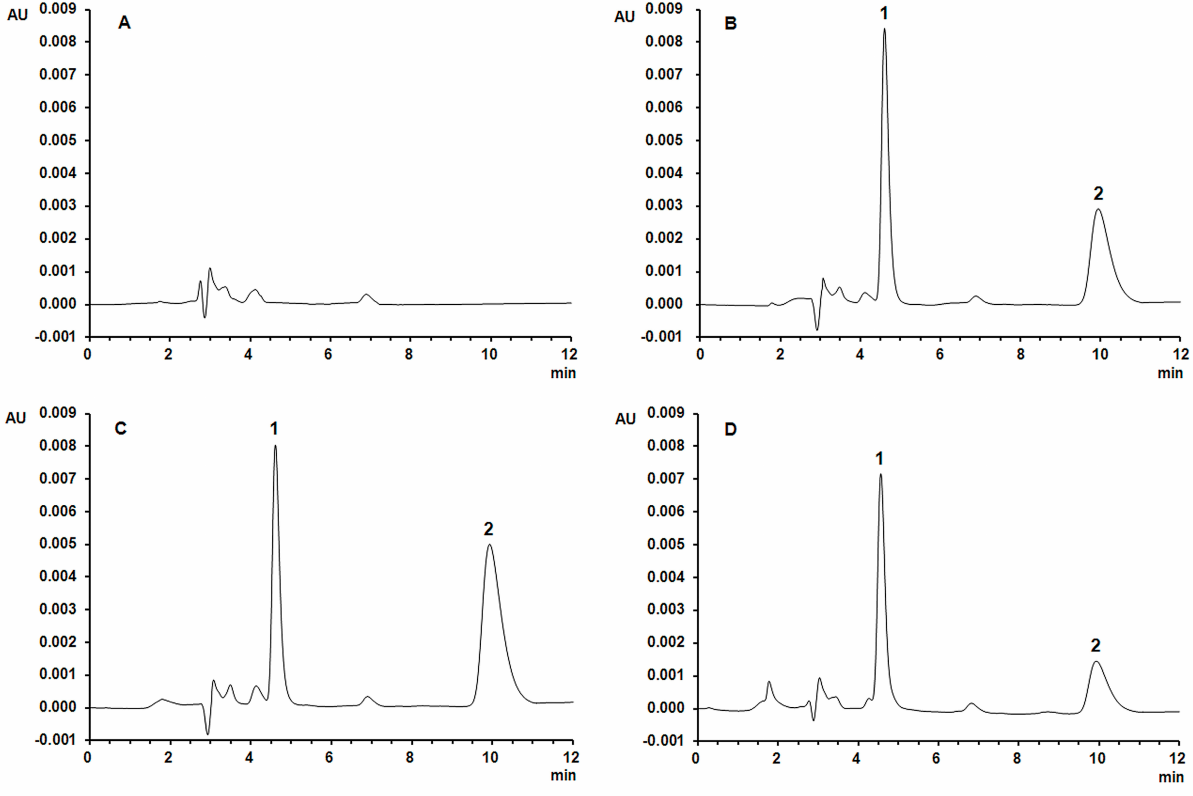
Figure 2. Typical chromatograms: ( A ) blank rat plasma; ( B ) blank rat plasma spiked with sinomenine and IS; ( C ) rat plasma sample after oral administration of sinomenine monomer; ( D ) rat plasma sample after oral administration of Sinomenium acutum extract. Peak 1: IS; peak 2: sinomenine.